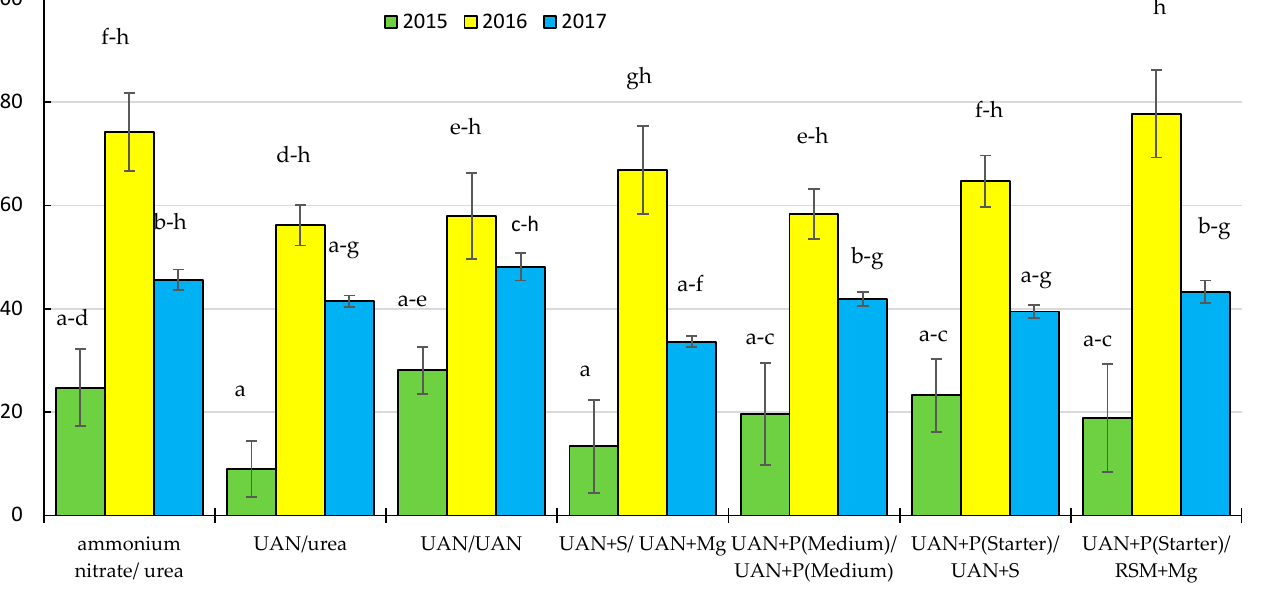
Figure 5. Share of maize grain in N accumulation (HI N ) depending on a study year ( a ) and applied fertilization ( b )—mean ± SE; data marked with same letters do not differ significantly at p < 0.05; figure ( a ) years of experiment (2015, 2016 and 2017), figure ( b ) number of object (I–VIII)—see Table 1. In this study, the recovery of N from fertilizers (R N ) ranged from 9 to 77% (Figure 6) The lowest R N was observed in the first year in the treatment fertilized with UAN before sowing and with urea as a top-dressing application. The highest R N was determined in the second year of the experiment, in the treatment fertilized with UAN + P (Starter) before sowing and with UAN + Mg top-dressing.